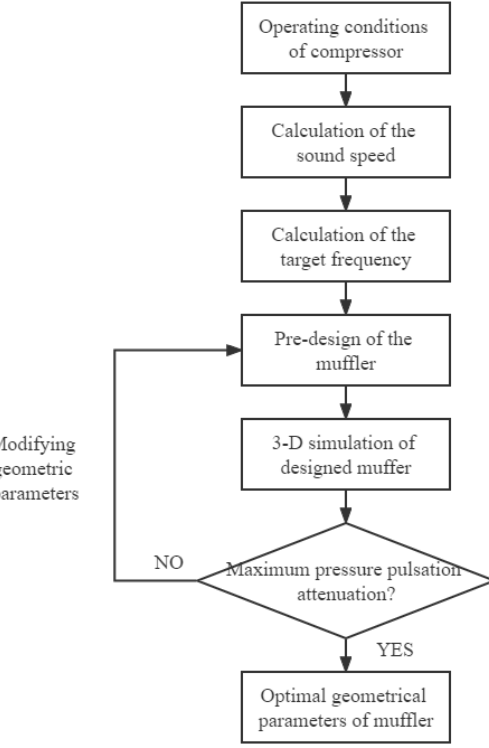
Figure 24. Flow chart of the design method for the muffler.